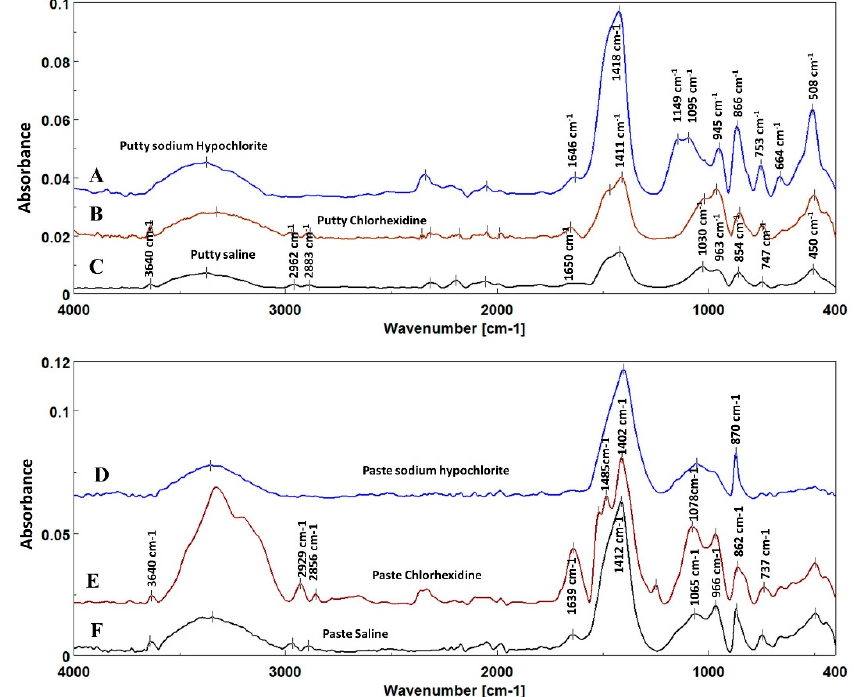
Figure 4. Fourier Transform Infrared spectra of EndoSequence fast-set putty (top A–C) and premixed regular-set paste (bottom D–F) show the changes in different bands after immersion in 5.25 % sodium hypochlorite (A and D, blue) and 2% chlorohexidine gluconate (B and E, brown) compared to that immersed in saline (C and F, black). Table 2. Means ± standard deviations of EndoSequence (fast-set putty and regular-set paste) carbonate/phosphate ratio after immersion in different irrigating solutions.